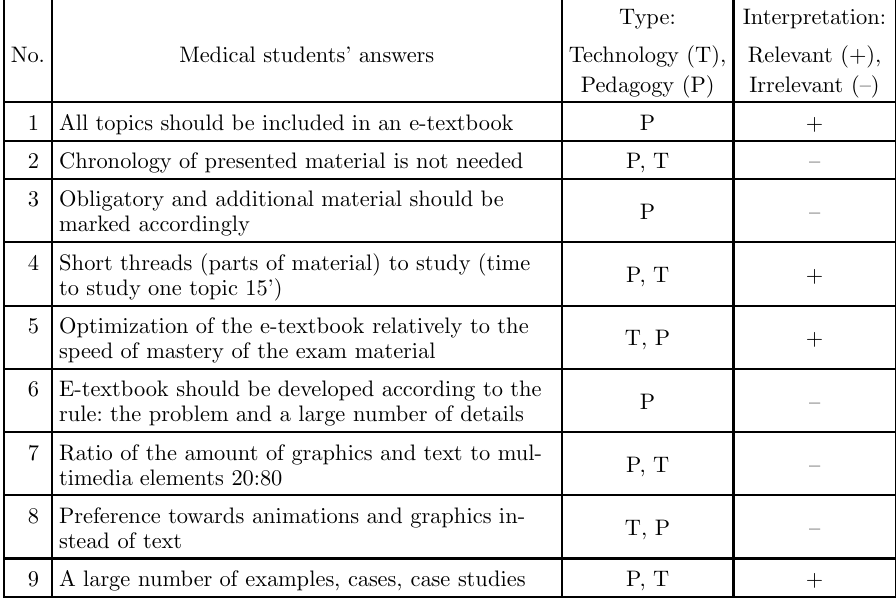
Table 1. Medical students’ expectations regarding